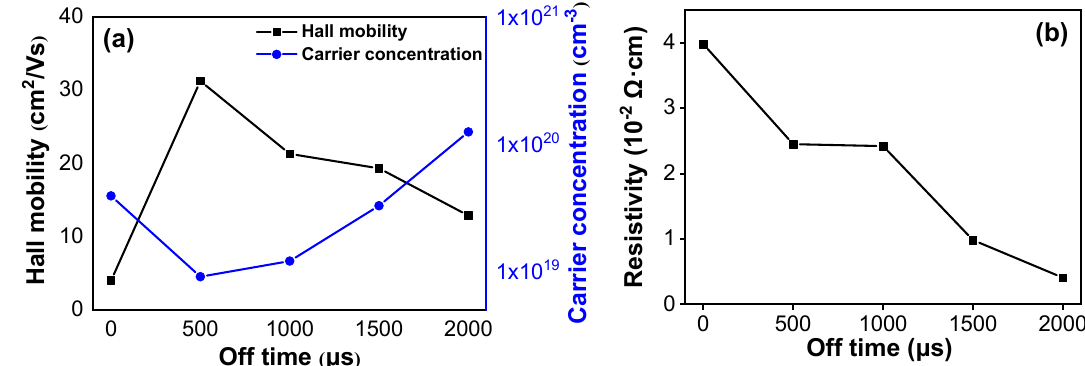
Figure 6. Electrical properties of ITZO films deposited at different pulse off-times: ( a ) the carrier mobility and carrier concentration and ( b ) the films’ resistivity.